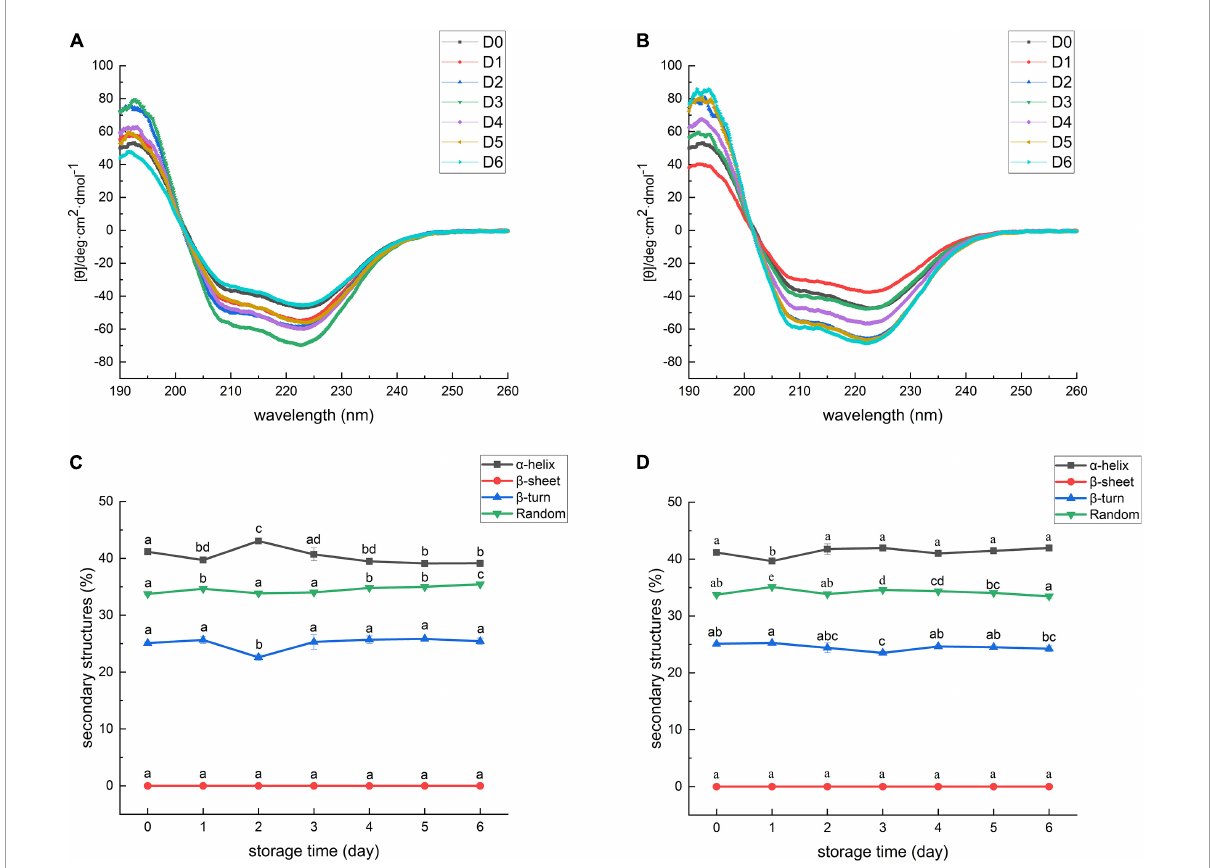
FIGURE4 Circular dichroism spectra of myofibrillar protein from sea bass. (A) Control; (B) SMF. D0, 1, 2, 3, 4, 5, 6 represent day 0, 1, 2, 3, 4, 5, 6, respectively. Secondary structure of myofibrillar protein from sea bass. (C) Control; (D) SMF. Different lowercase letters on the top of bars indicated statistically significant differences between samples ( p <